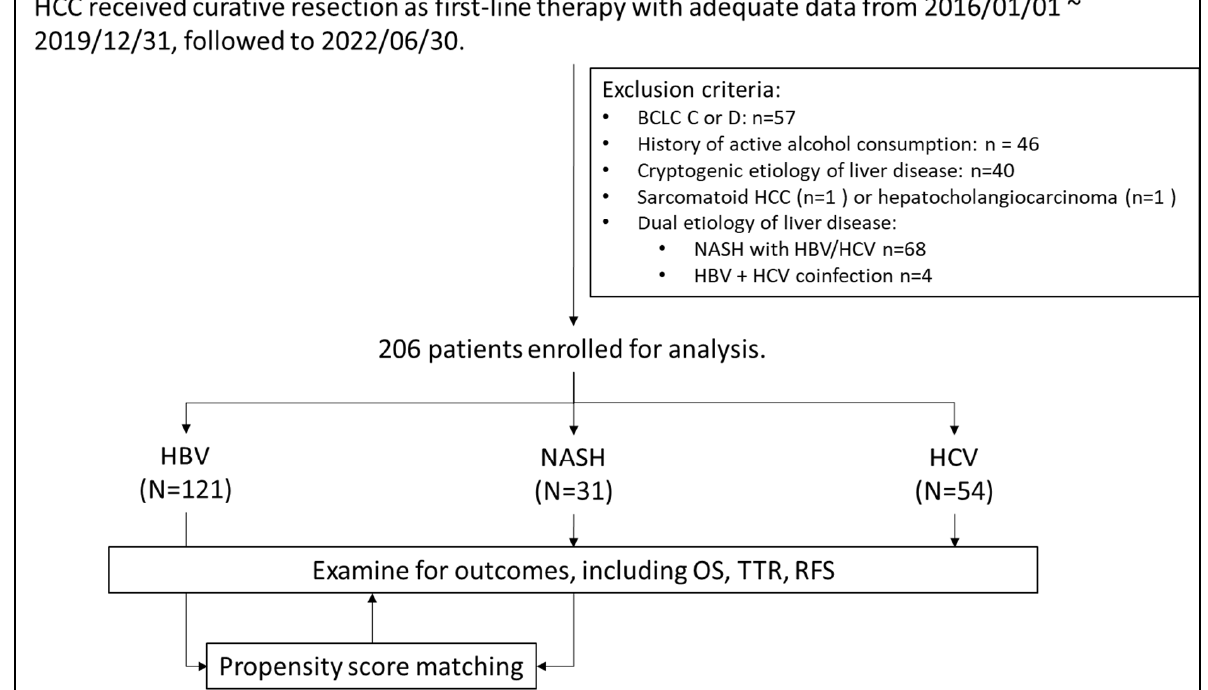
Figure 1. Algorism of patient selection. Table 1. Baseline characteristics of patients according to etiology of liver disease.